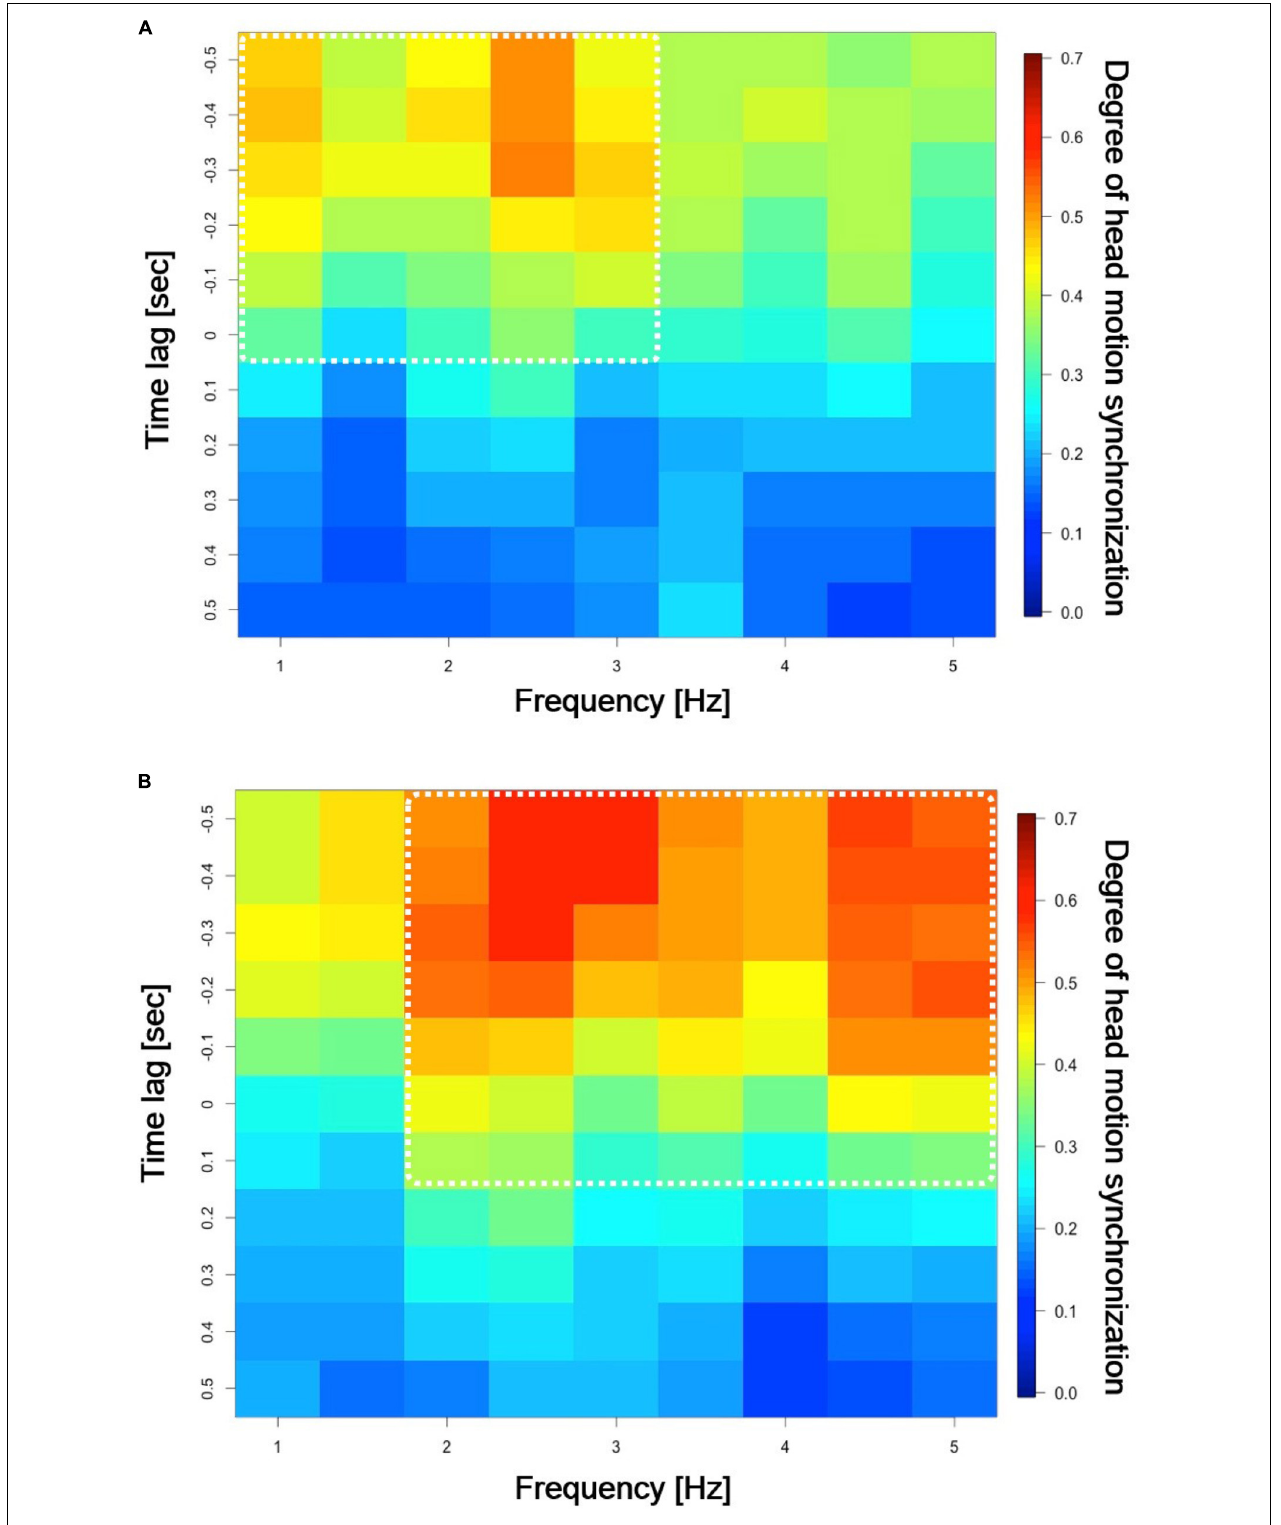
FIGURE 5 | Incidence of head motion synchronization for low and high empathy conditions. The incidence of head motion synchronization is illustrated by a continuous spectrum of colors from red to blue. (A) Mean incidence of head motion synchronization during low empathy ( n = 23). (B) Mean incidence of head motion synchronization during high empathy ( n =